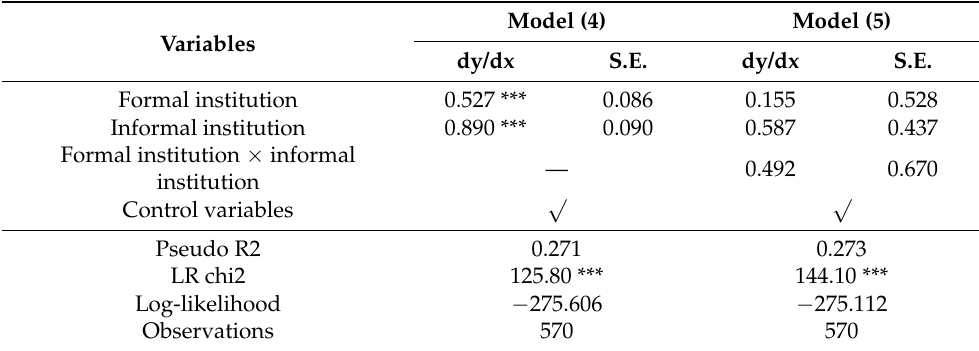
Table 4. Results of the effect of formal institution, informal institution, and their interactive term on farmers’ behavior to